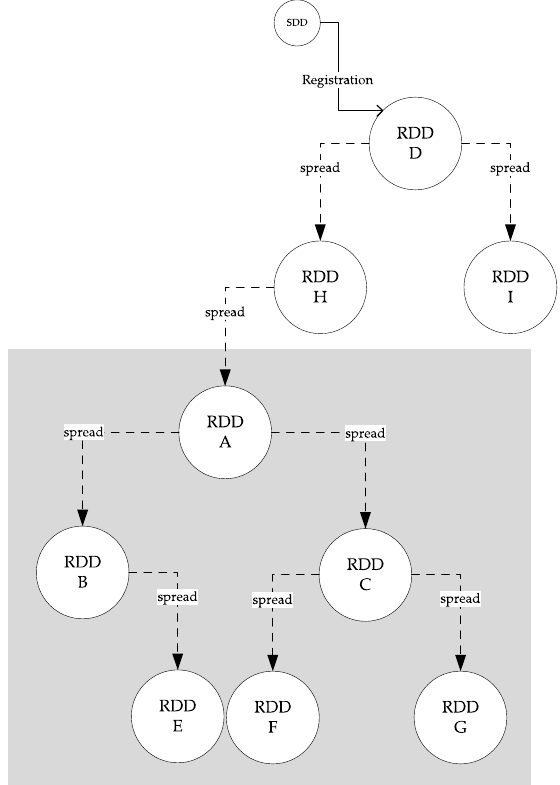
Figure 9. An example of the tree transformation in a case where more than half of the total RDDs cannot participate in validation.